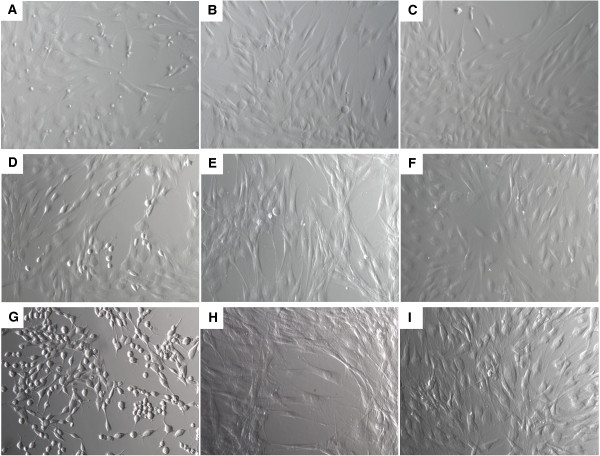
Morphology of HDFs stimulated with CM of M1 polarized, M2 polarized, or unstimulated macrophages. HDFs stimulated with CM of M1 polarized macrophages; 24 h (A), 72 h (D), and 144 h (G). After 24 h, most of the fibroblasts showed a spindle-shaped morphology although some rounded fibroblasts were seen. After 72 h, the fibroblasts adopted a rounded morphology that was most prominent after 144 h. HDFs stimulated with CM of M2 polarized macrophages; 24 h (B), 72 h (E) and 144 h (H). After 24 h the cells showed a spindle-like morphology, which was changed into an elongated spindle-like morphology after 72 h. HDFs stimulated with CM from unstimulated macrophages 24 h (C), 72 h (F), and 144 h (I). The fibroblasts showed a spindle-like morphology after 24 h, which was not changed in time.